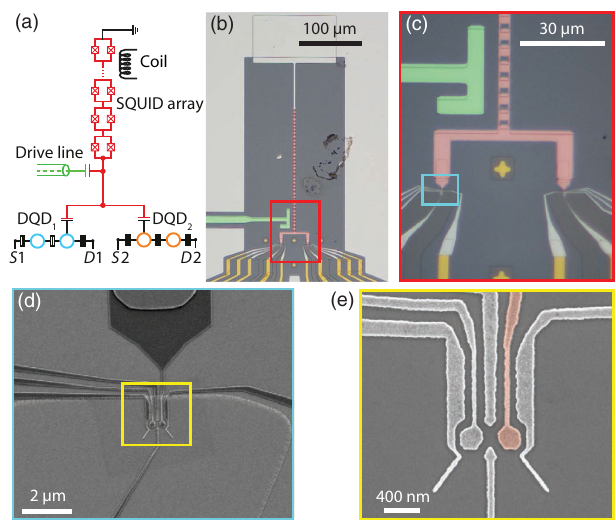
FIG. 1. Simplified circuit diagram and micrograph of the device. (a) Schematic of the device and control line: SQUID array resonator (red), drive line (green), two DQDs (cyan and orange), and an external coil (black). The color code is used throughout this paper. (b) False-color optical micrograph of the measured device. (c) Detail of (b) showing the resonator and its drive line coupled to both DQDs. (d) Scanning electron micro- graph (SEM) of the resonator connected to DQD 1 on the left. DQD 2 is defined as a mirrored copy of DQD 1 , separated from it by 42 μ m. (e) SEM micrograph of the gate structure used for defining the DQDs in the GaAs = AlGaAs heterostructures. (d) and (e) are images of identically designed devices not used in the